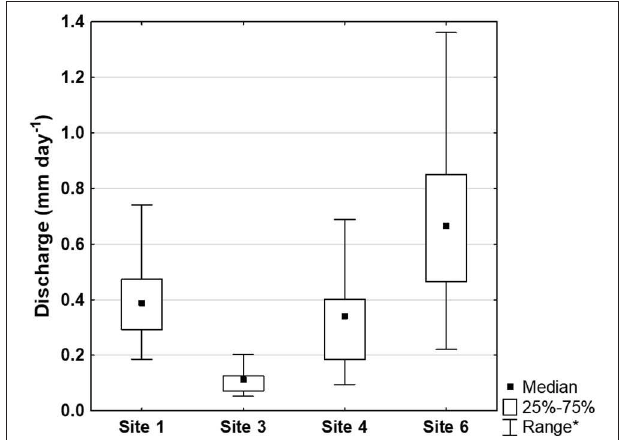
FIGURE 3 | Normalized discharge (mm d-1) from January 10, 2012 to January 9, 2013 at Sites 1, 3, 4, and 6, based on stage-discharge curves developed during the pulse additions and stage collected with dataloggers. *The range excludes outliers (point which falls more than 1.5 times the interquartile range above the third quartile or below the first quartile) and extremes (point which falls more than 3.0 times the interquartile range above the third quartile or below the first quartile).